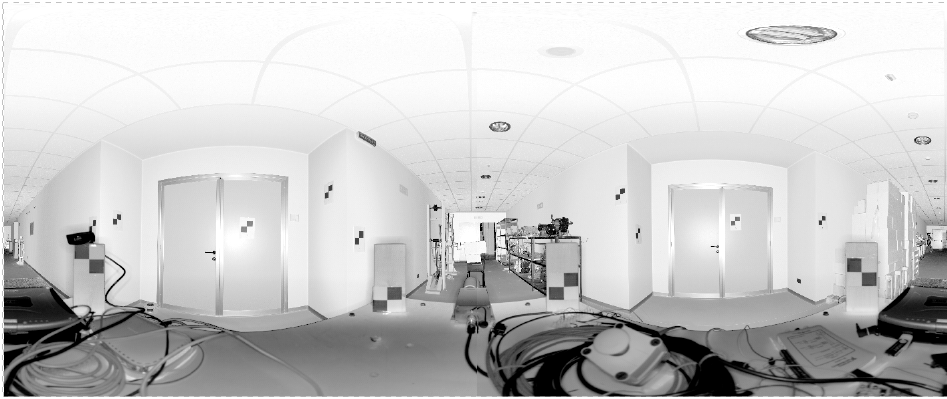
Figure 6. 360° view of the scan performed in GEXCEL laboratories. Figure 6. 360 ◦ view of the scan performed in GEXCEL